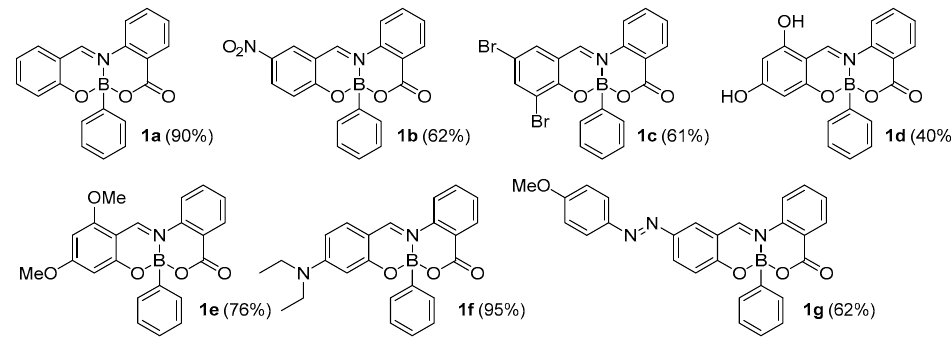
Figure 1. Boron complexes obtained through the one-pot multicomponent reaction, and corresponding yield.